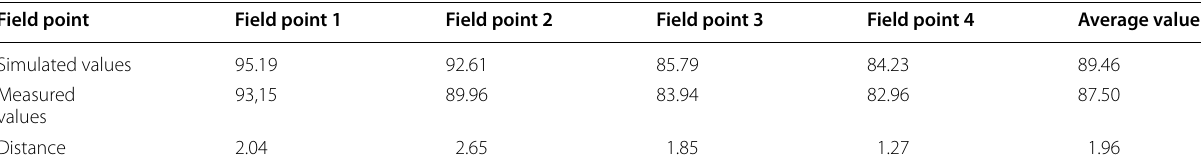
Table 5 Comparison of simulated and measured values of effective sound pressure level of radiated noise at four field points in test gearbox (dB(A))